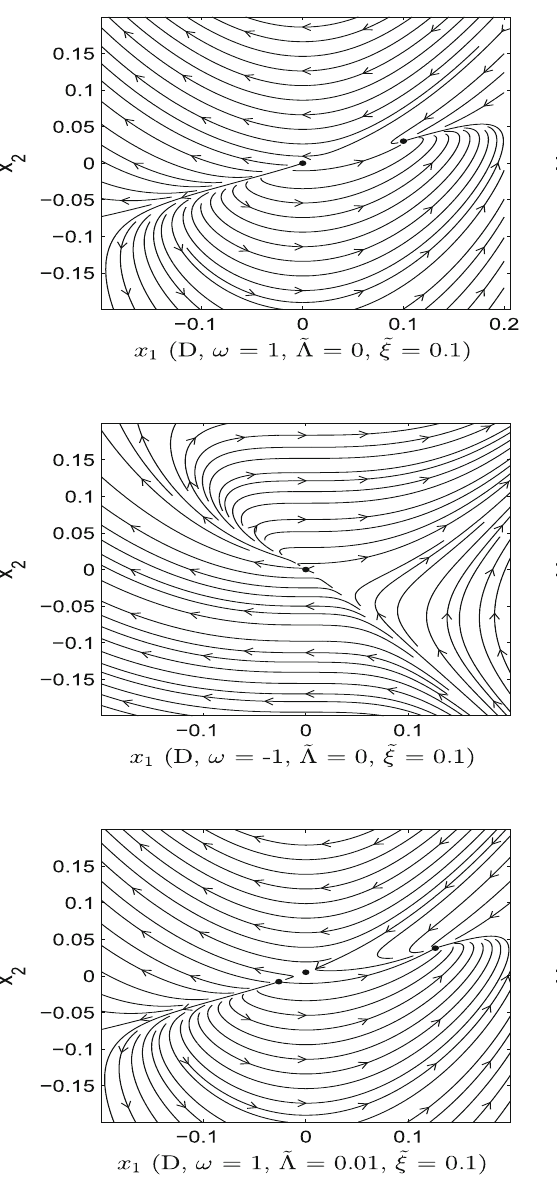
tion (cid:13) 2 = 0 as a parabola curve in the plane ( ˜ (cid:4) = − 3 ˜ ξ 2 . This parabola divide the plane ( ( 1 + ω) 2 distinct regions 4 and each region has a characteristic behav- ior for the fixed points. All these behaviors are displayed in the bifurcation diagram in Fig. 16 showing a similar behavior to that of saddle-node bifurcation. The phase space diagrams,